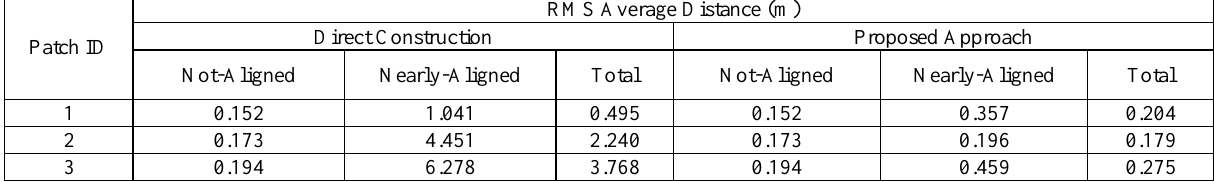
Table 2. Comparison of the computed RMS distances of the Direct Construction method and the Proposed Approach Patch